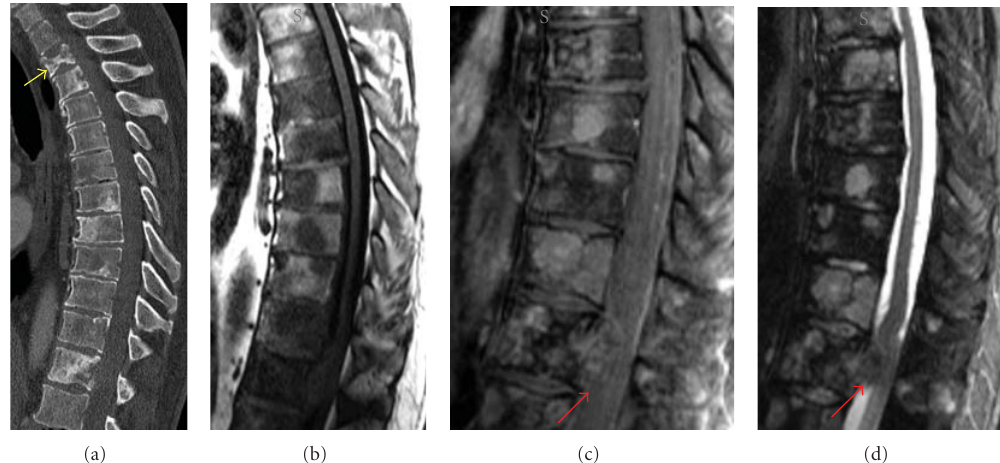
Figure 8: Sagittal CT reformation (a) shows multiple lytic and blastic metastatic breast cancer lesions in the thoracic spine with a compres- sion fracture in the upper thoracic spine (yellow arrow). Sagittal T1-weighted image (b) shows multiple hypointense lesions, many of which enhance on the postcontrast T1-weighted MR (c). The STIR image (d) depicts both hyperintense (lytic) and hypointense (blastic) lesions. A mildly enhancing epidural component compresses the thecal sac (red arrows).